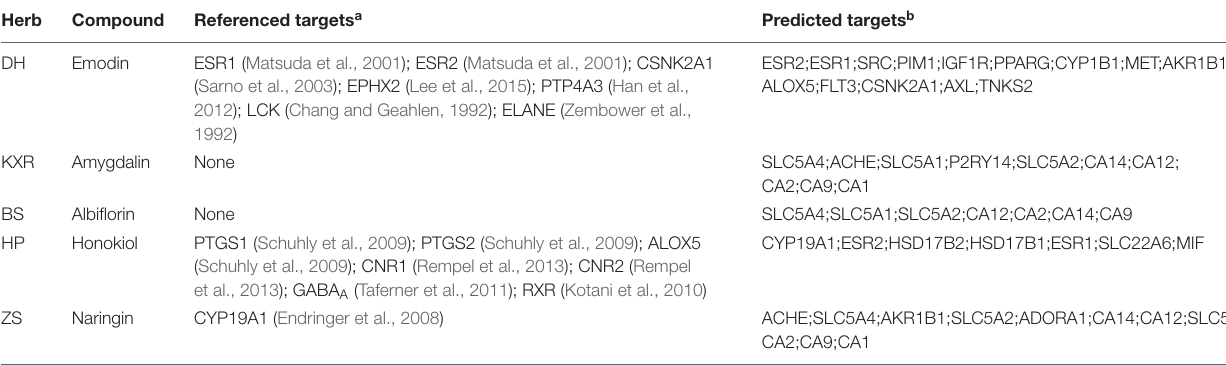
TABLE 1 | Referenced and predicted targets of MZRW representative compounds.